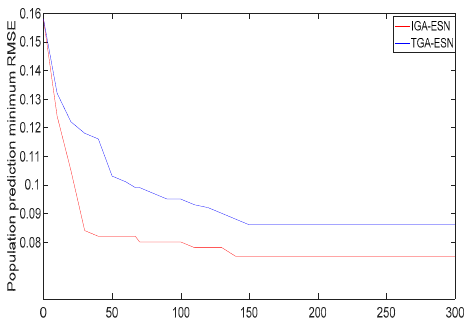
Figure 13. Minimum standard deviation curve of population prediction.